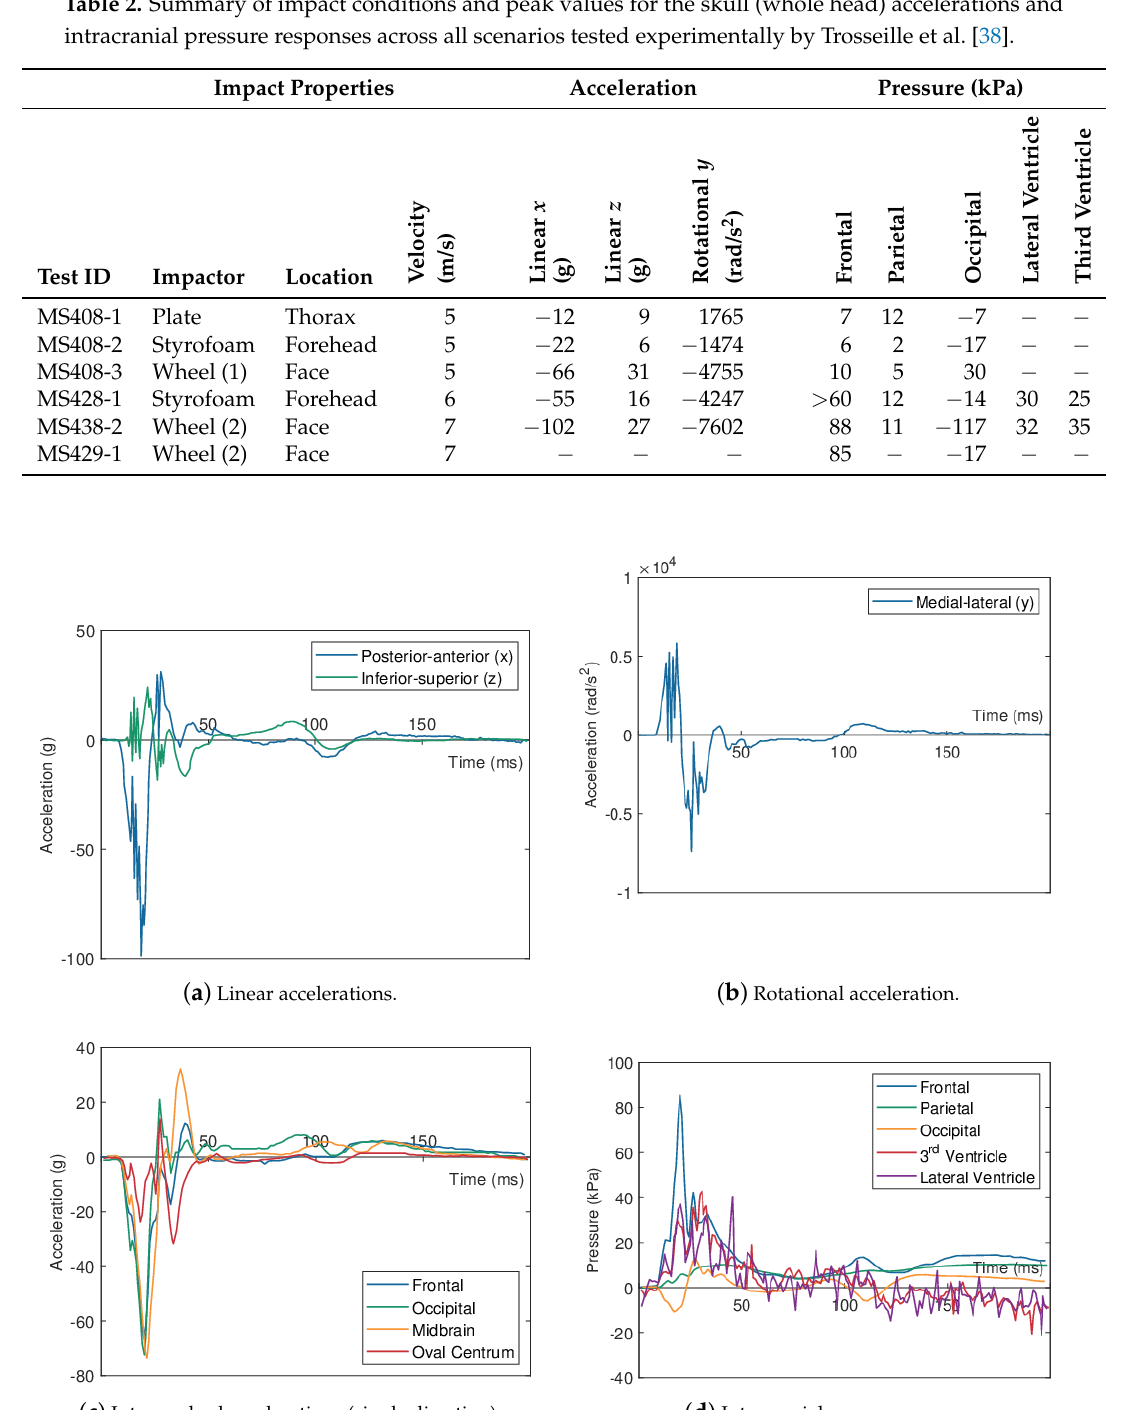
Figure 2. Cadaver response to experiment MS428-2 (adapted from Trosseille et al. [38]). Kinematic response of the skull: ( a ) linear accelerations in the posterior-anterior ( x ) and inferior-superior ( z ) directions, ( b ) rotational acceleration about the medial-lateral axis ( y ). Intracranial response: ( c ) intracerebral accelerations at transducers in white matter within the frontal and occipital regions of the brain, in the lenticular nucleus of the mid-brain and at the oval centrum provided as magnitudes against time in a single direction, ( d ) pressure response recorded at transducers in the frontal, parietal and occipital regions of the arachnoid space and third and lateral ventricles of the